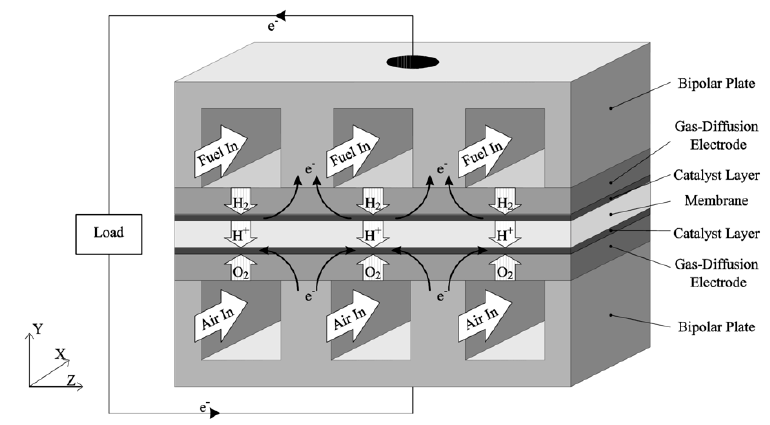
Figure 1. Proton exchange membrane fuel cell (PEMFC) schematic [2].